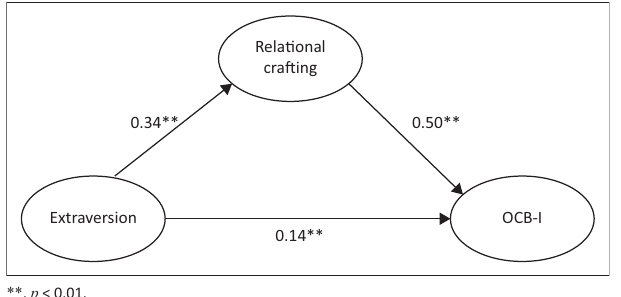
Rela(cid:27)onal cra(cid:22)ing